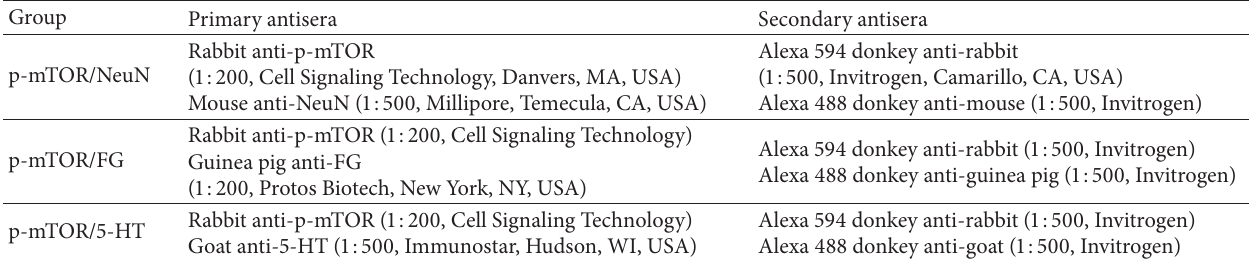
Table 1: Antisera used in each